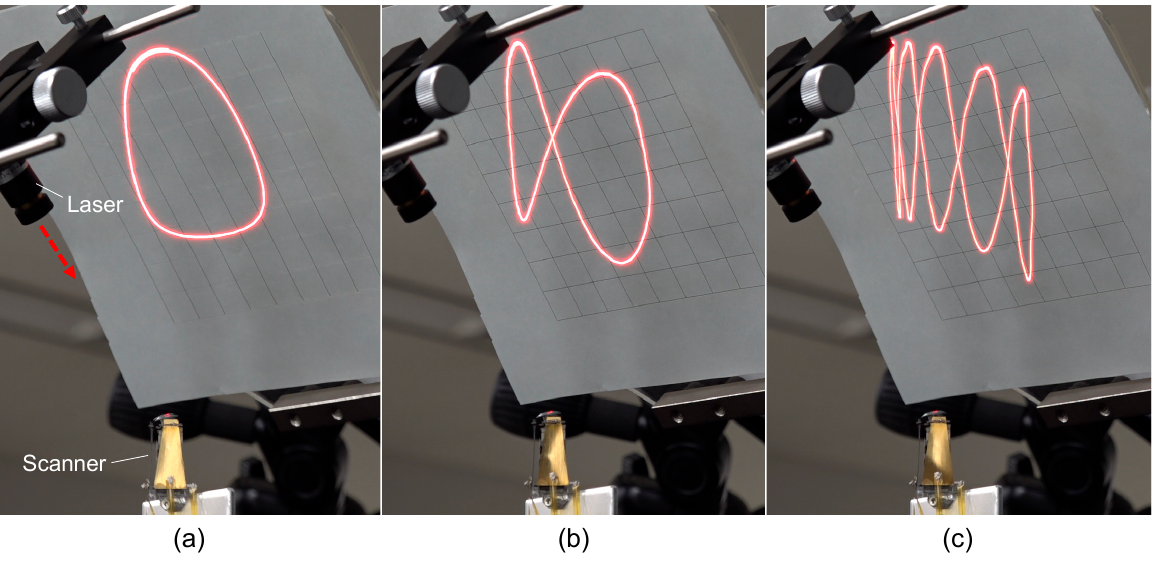
Figure 14. 2-DoF scan demonstrations. ( a ) Circle, and Lissajous curves with the frequency ratio of ( b ) 2 and ( c ) 5.